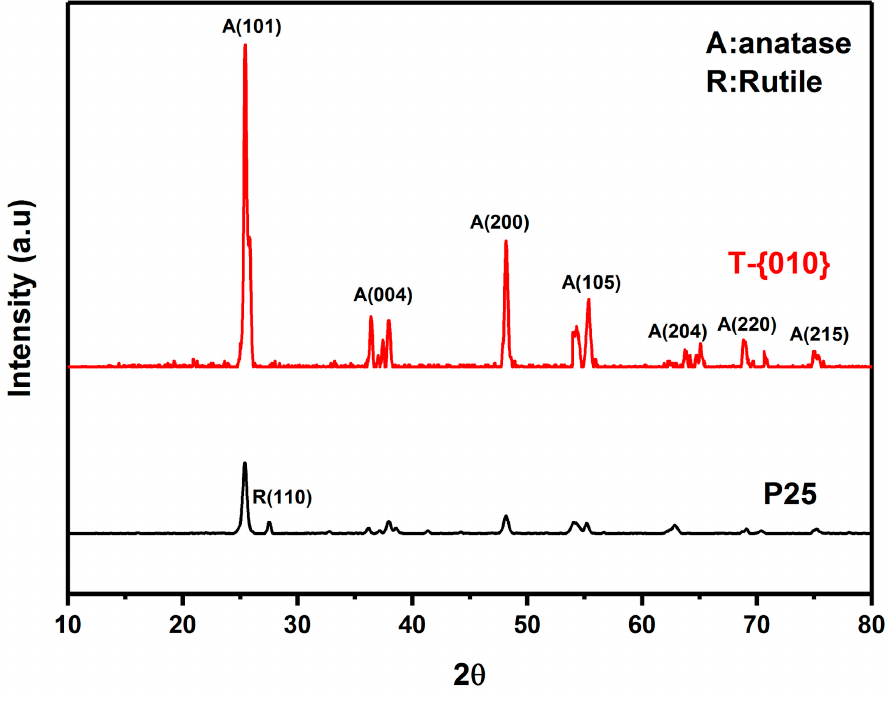
Figure 1. XRD patterns of P25 and T-{010}.